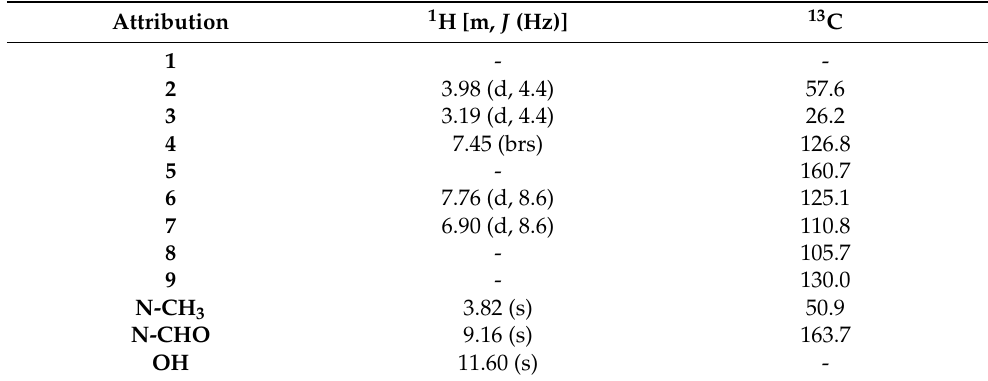
Table 1. 1 H (500 MHz) and 13 C (125 MHz) data of 1-formyl-5-hydroxy- N -methylindolin-1-ium ( 1 ) in DMSO-d 6